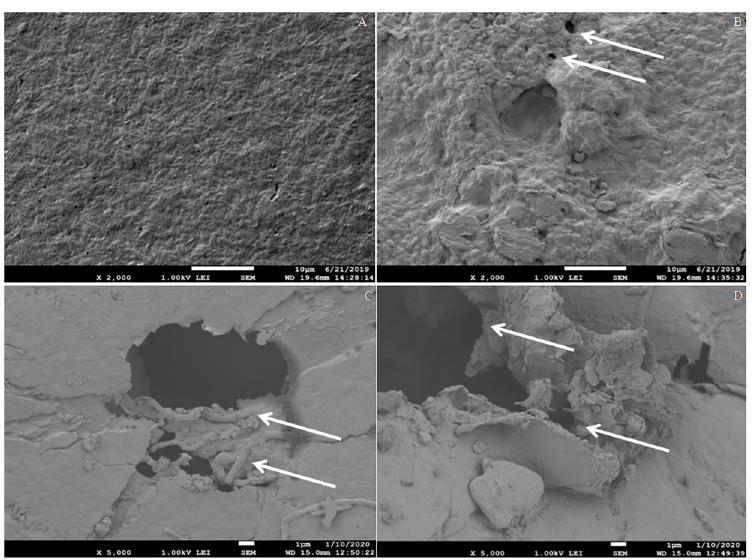
Fig 4. Morphological changes in SEM micrographs of PHB film degraded in soil burial method after incubation with (A) Control PHB film without treatment, and Aeromonas caviae Kuk1-(34) sp after (B) 15 days (C) 30 days (D) 45 days.